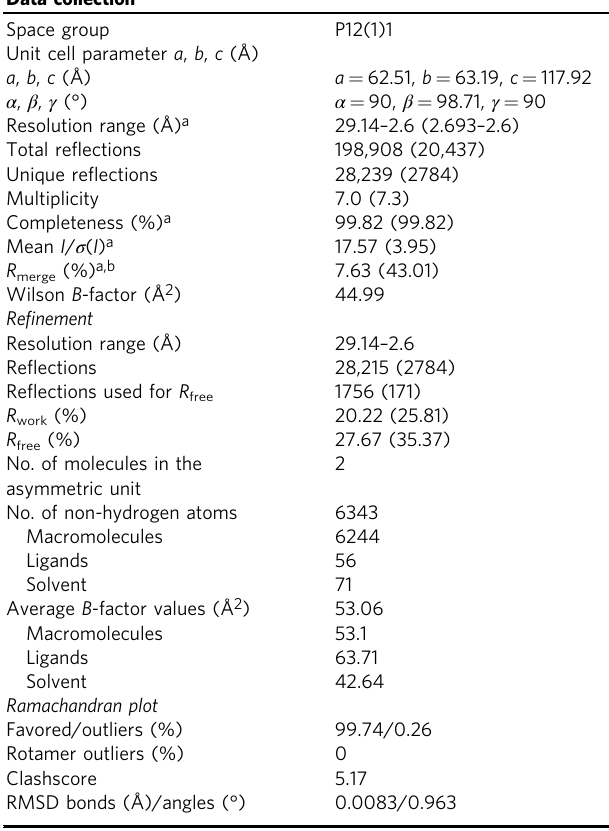
Table 1 Data collection and re fi nement